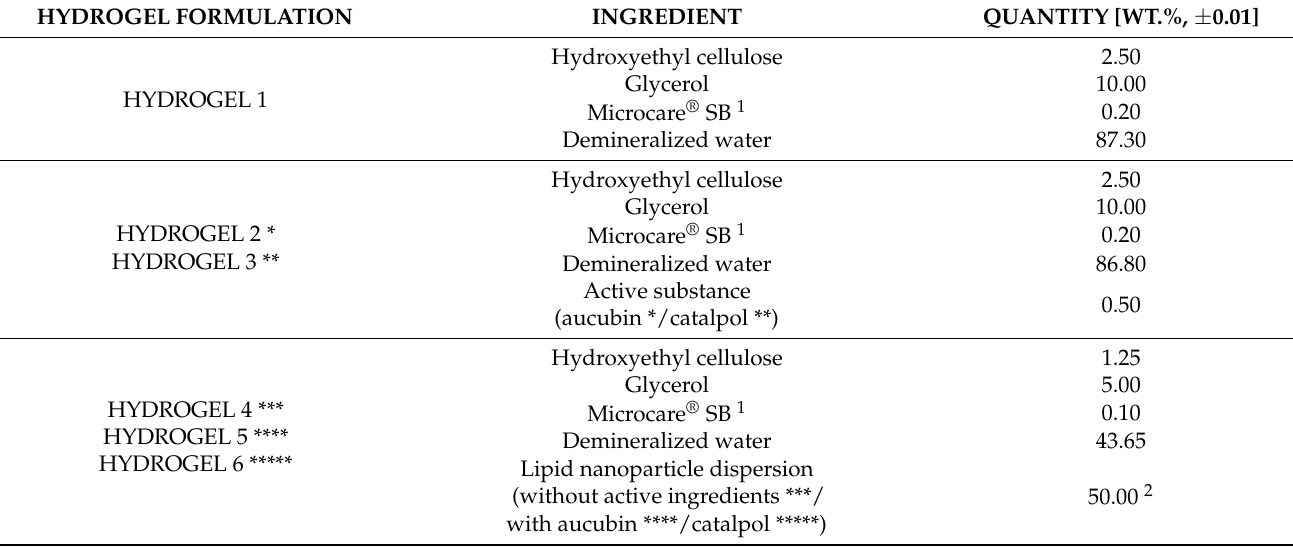
Table 1. Compositions of hydrogel formulations prepared within the framework of the study. HYDROGEL